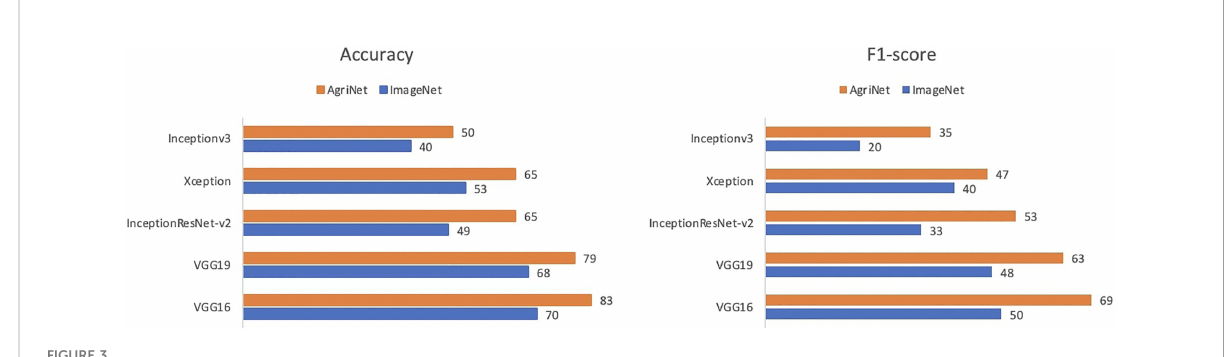
FIGURE 3 Models comparison on rice pests and diseases dataset.